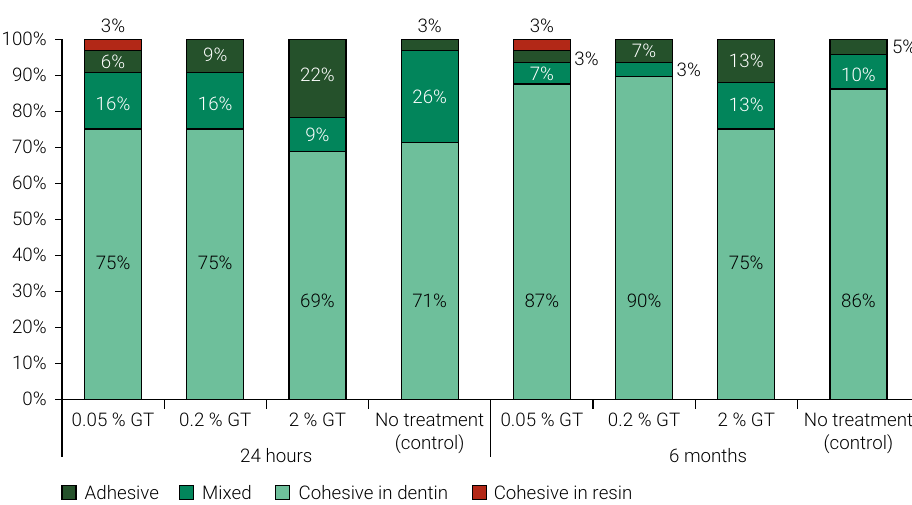
Adhesive Mixed Cohesive in dentin Cohesive in Figure 1. Bar diagram of the relative frequency (%) of failure modes, according to the concentration of the solution containing green tea extract applied to the dentin and the storage time.